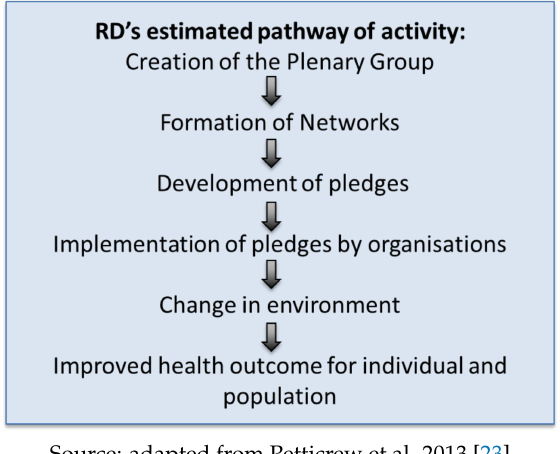
Figure 3. Simple logic model. RD: the Public Health Responsibility